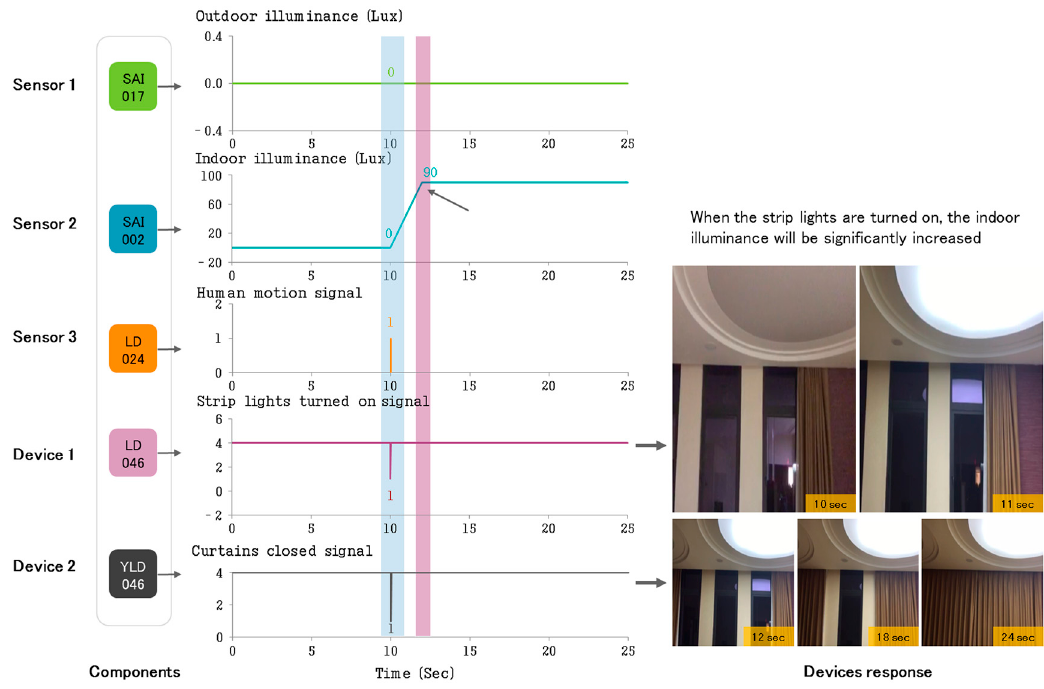
Figure 10. Collaborative control process of multiple sensors and devices.